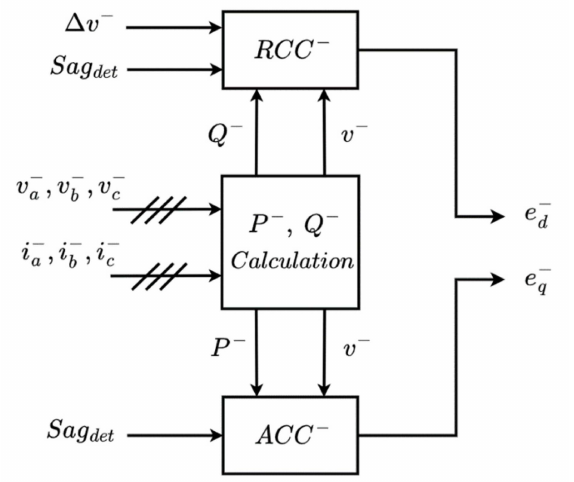
Figure 10. Negative sequence control